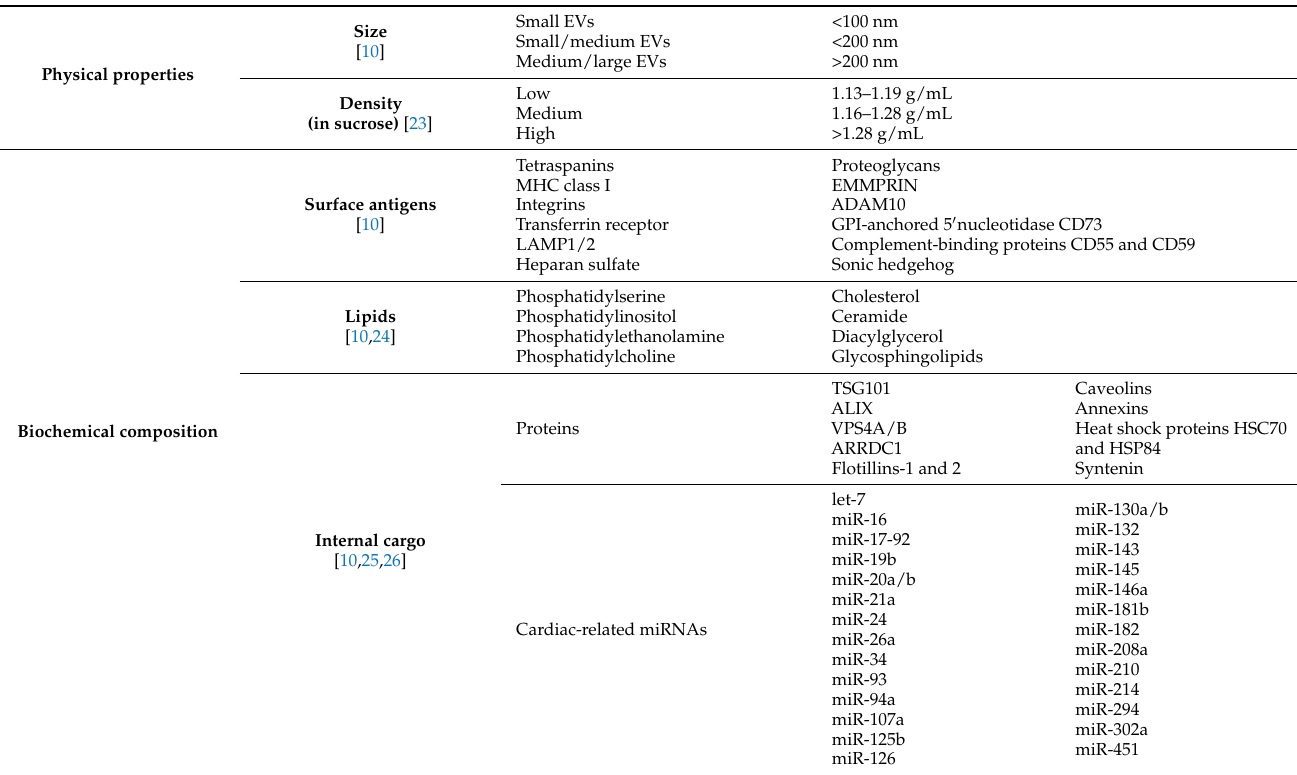
Table 1. Requirements for extracellular vesicles’ separation and classification based on their physical and biochemical properties as well as donor cell